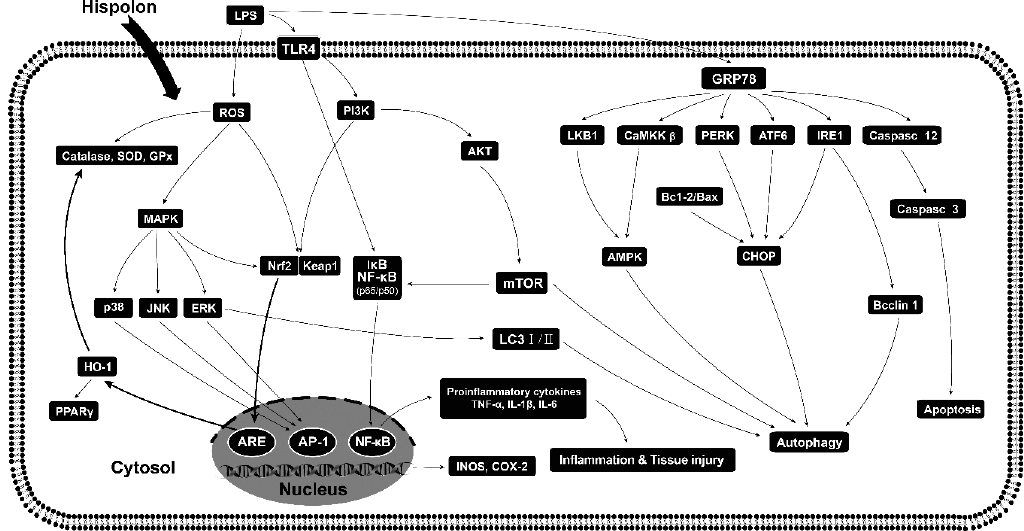
Figure 9. A scheme for the protective effect of hispolon against LPS challenge inflammation.